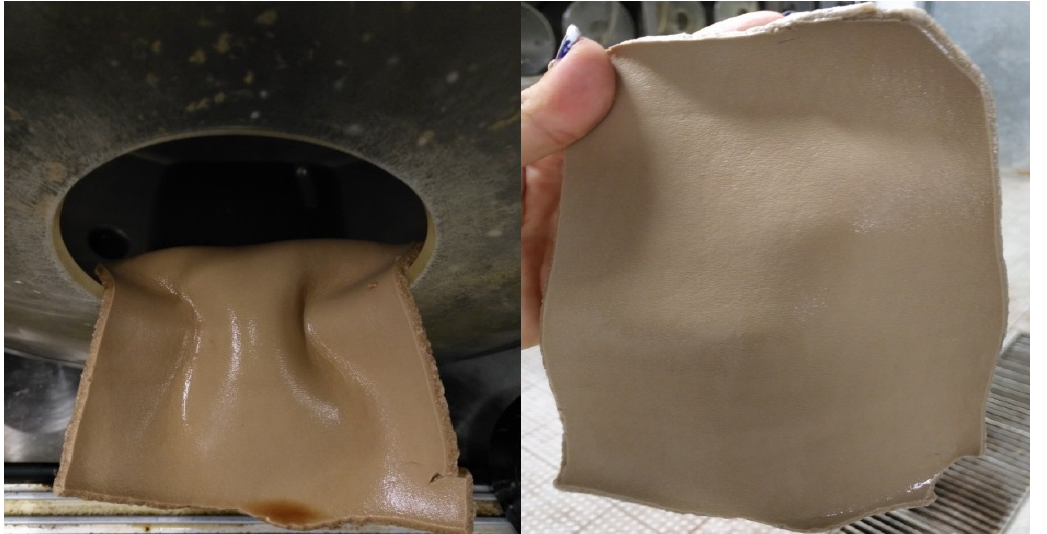
Figure 8. Tanned leather.